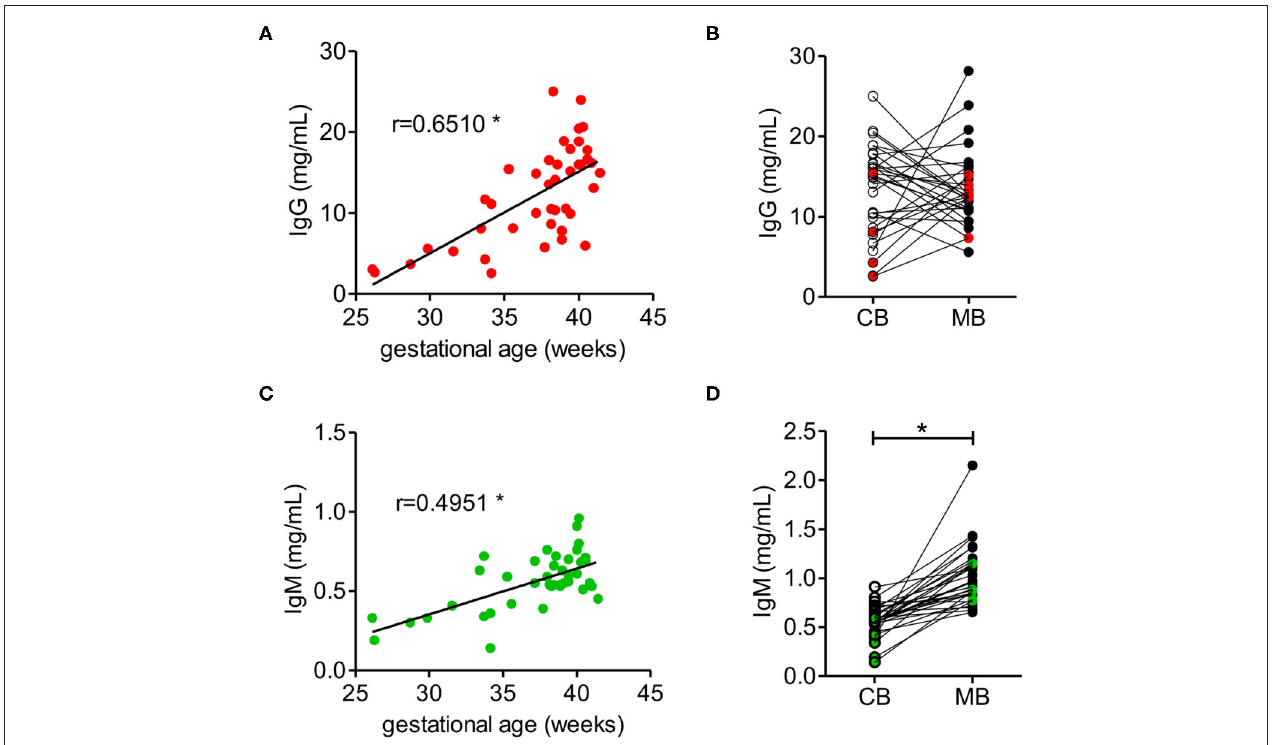
FIGURE 1 | IgM and IgG concentrations in cord blood depend on the gestational age. (A) IgG concentration of cord blood samples dependent on the gestational age ( n = 42). (B) IgG concentrations of cord blood (CB) and matched maternal blood (MB) ( n = 31). Red dots indicate samples from pre-term neonates ( n = 5). (C) IgM concentrations of cord blood dependent on the gestational age ( n = 42). (D) IgM concentrations of cord blood (CB) and maternal blood (MB) ( n = 31). Green dots indicate samples from pre-term neonates ( n = 5). Results with p -value < 0.05 are marked with asterisks.